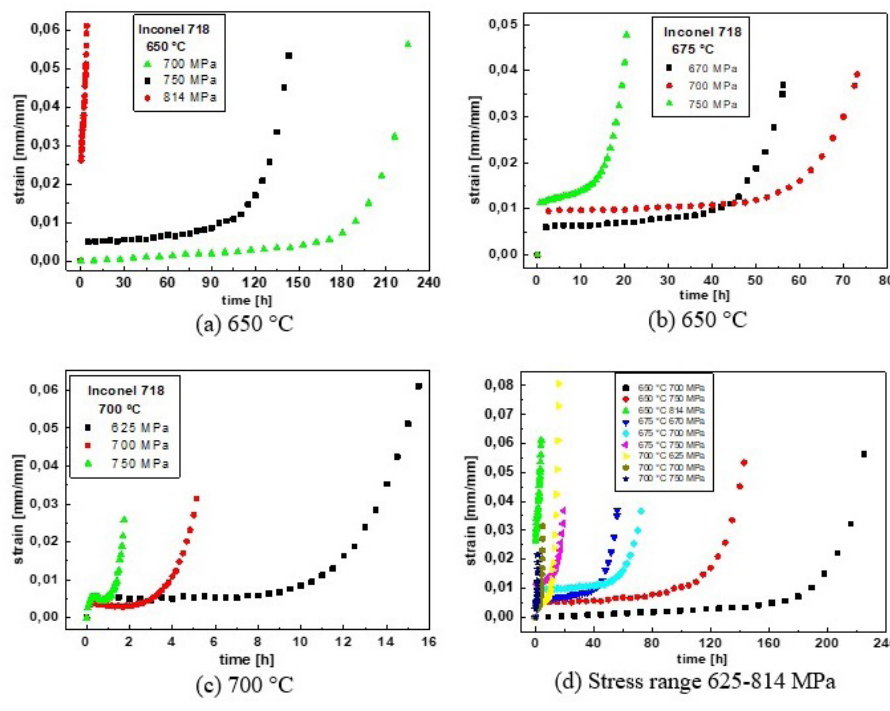
Figure 9. Creep curves of Inconel 718